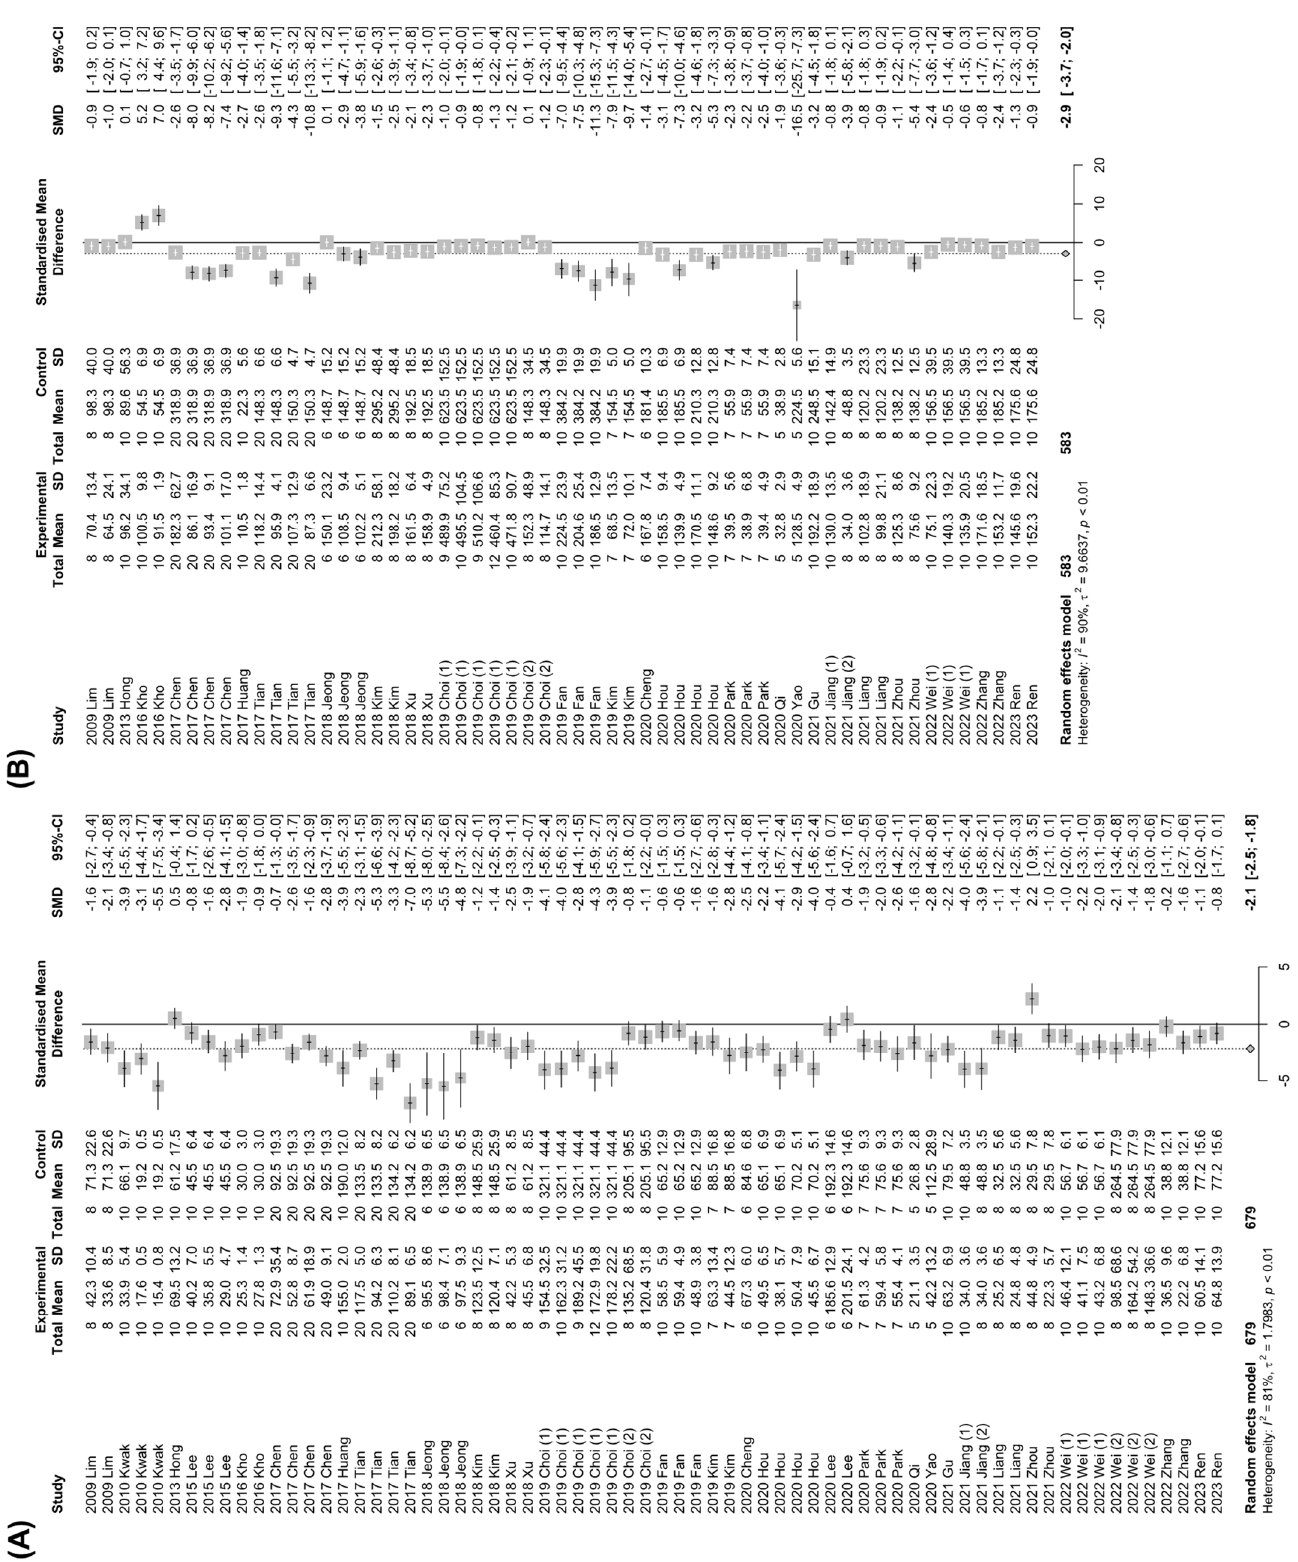
Figure 3. The effect of Panax ginseng on the levels of liver injury markers in NAFLD-induced animals. Forest plots for comparison: ( A ) Alanine aminotransferase (ALT) levels [7,19,20,23,24,27–32,35–41,43–45,47–50,52,54–56,58]. ( B ) Aspartate aminotransferase (AST) levels [19,23,27–32,35–41,44,45,47–50,52,54–56,58]. SD, standard deviation.